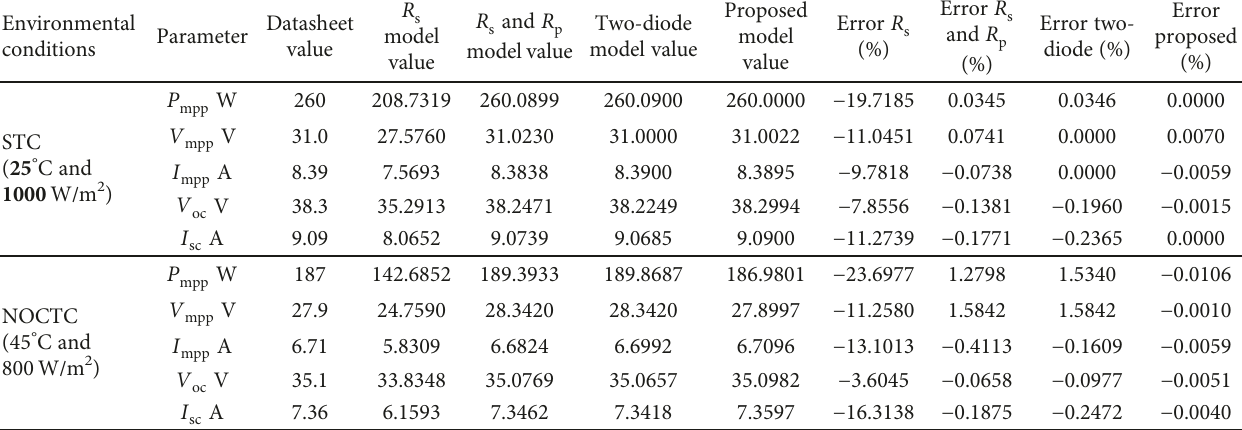
Table 8: Comparison of R KD260GX-LFB2 PV module